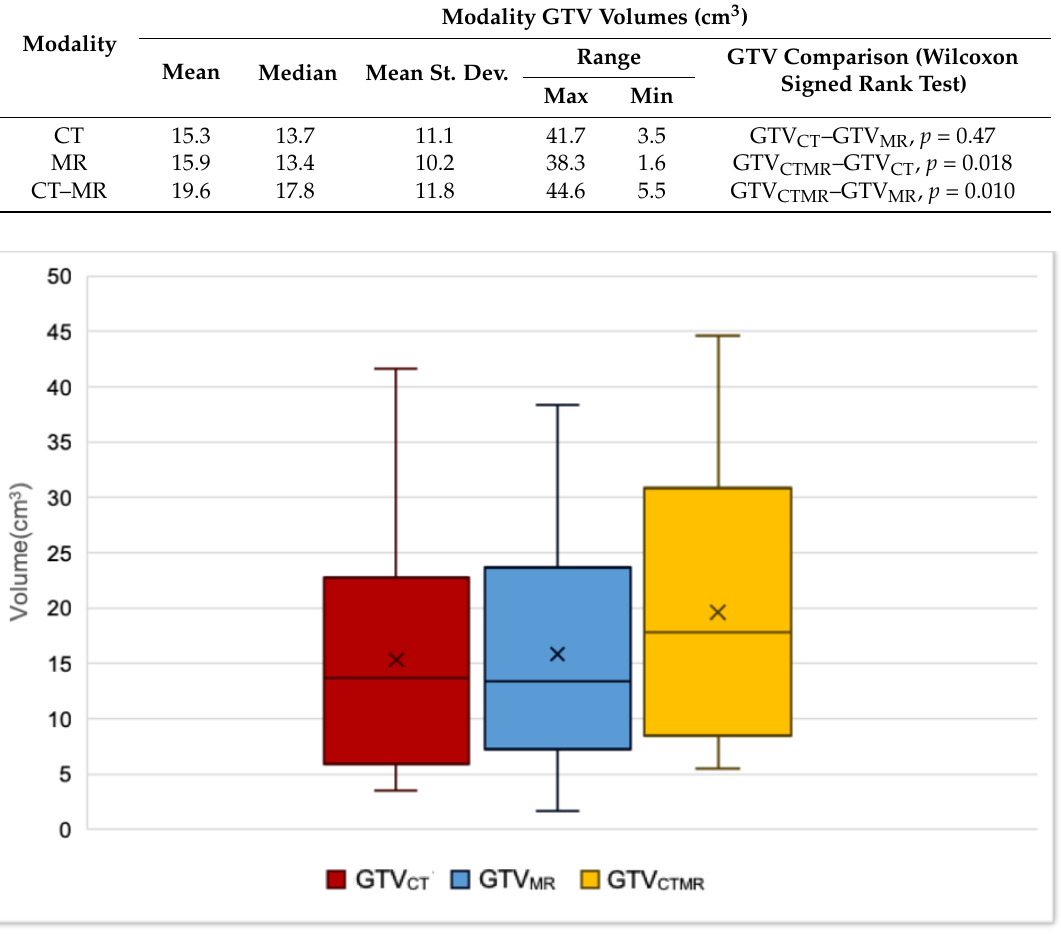
Figure 2. Box plot summarising volumes of GTV CT (red), GTV MR (blue) and GTV CTMR (yellow). The x denotes the mean, and the horizontal line in each box the median value.